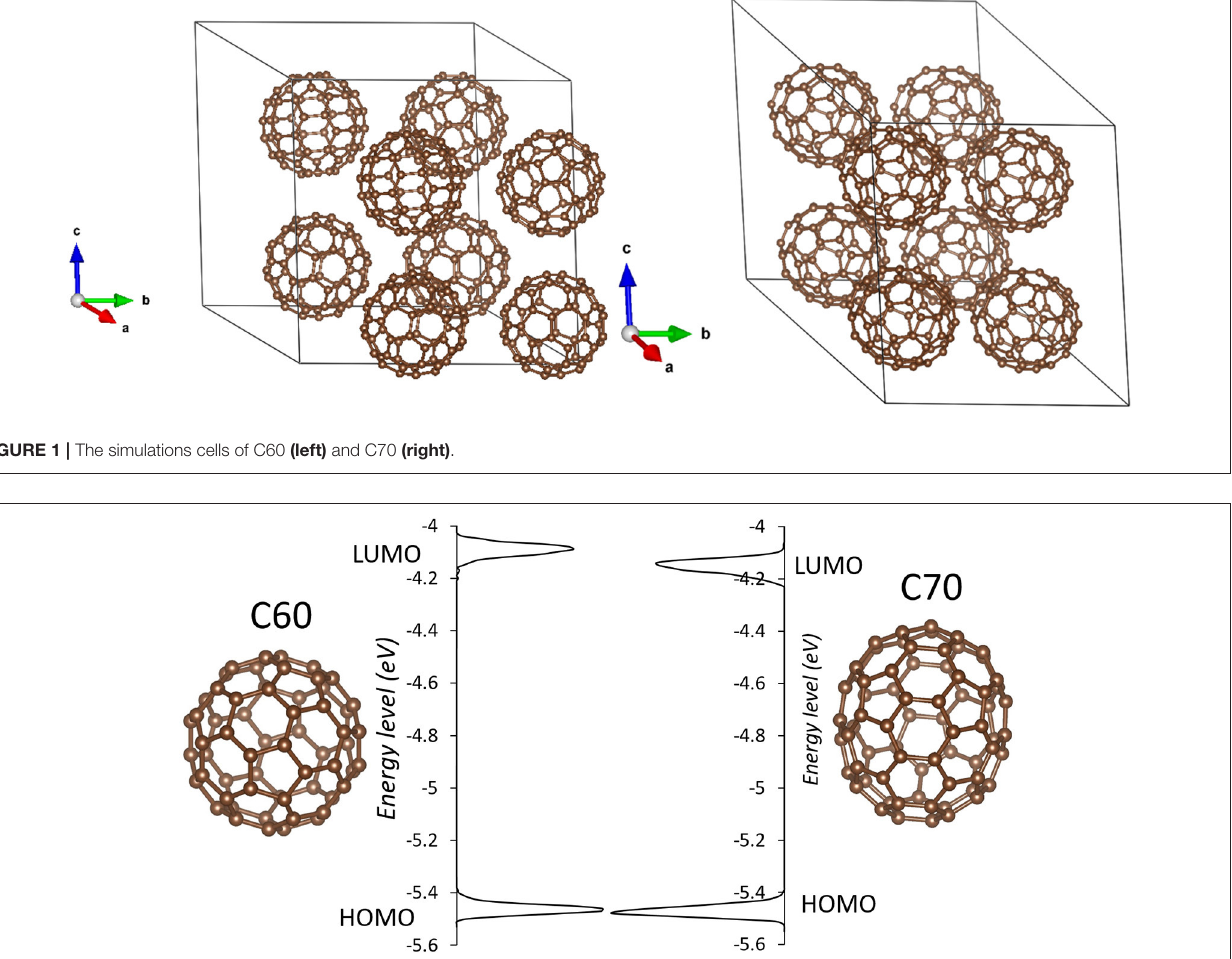
FIGURE 2 | The distributions of HOMO and LUMO levels in C60 (left) and C70 (right) during molecular dynamics in solid state. Individual molecules are shown next to respective plots.